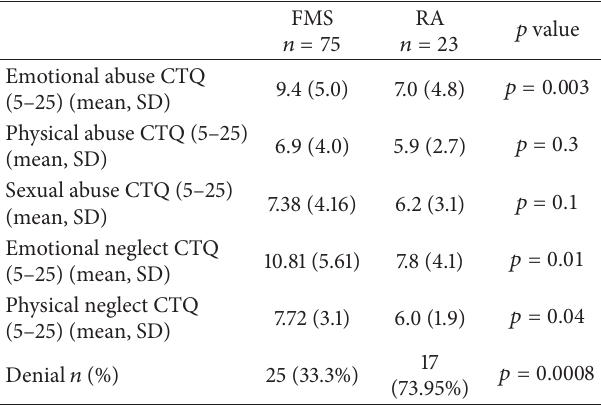
Table 8: Comparison of health status reports (assessed by the Short Form (36) health survey) of patients with FMS and patients with RA ( 𝑡